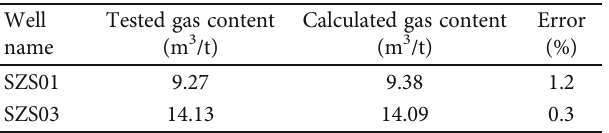
Table 4: Comparison of calculated and tested gas content in block W.